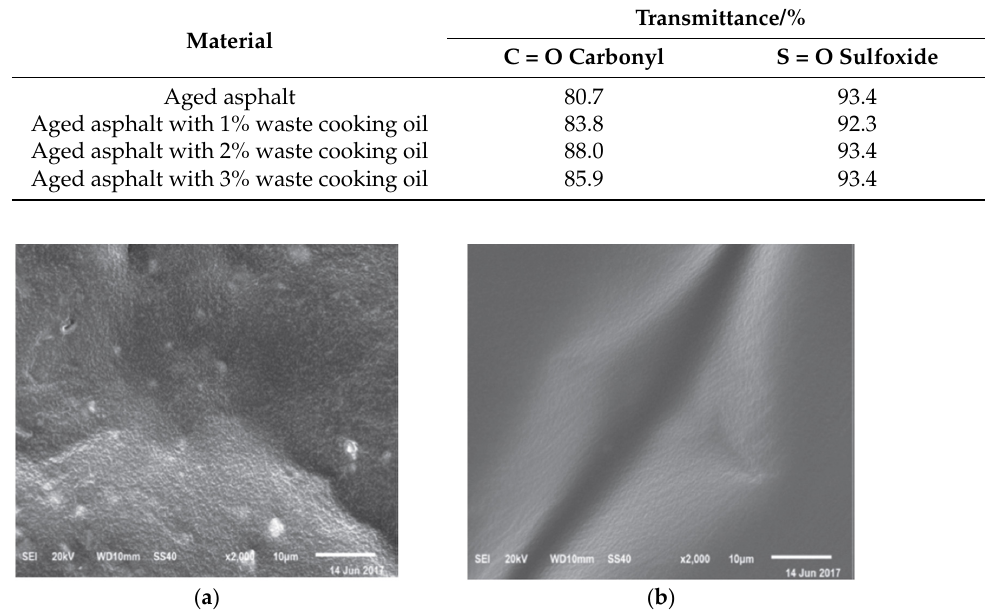
Figure 3. SEM image of aged and rejuvenated-asphalt [63]. ( a ) Aged asphalt, ( b ) rejuvenated-asphalt.